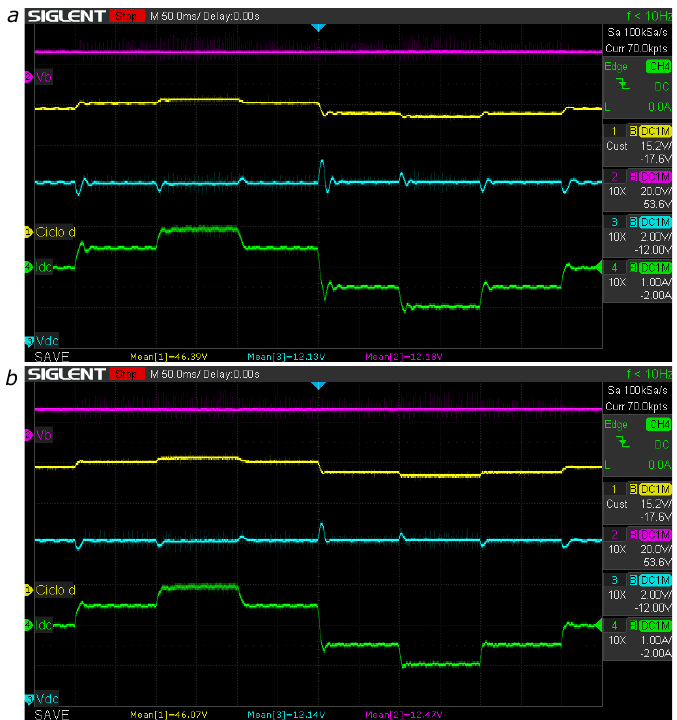
= 12 V (unitary gain mode) using ( a ) PI ref